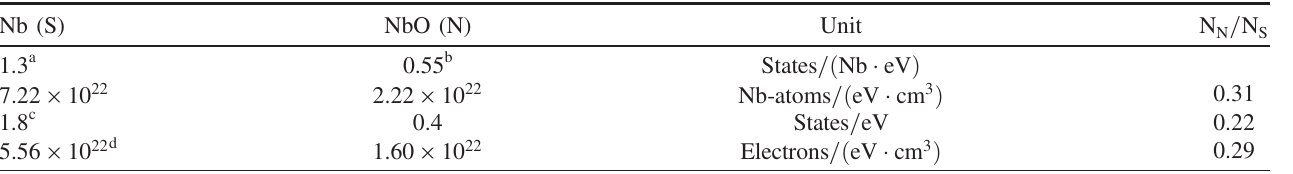
TABLE II. Density of states (DOS) of Nb and NbO. Nb